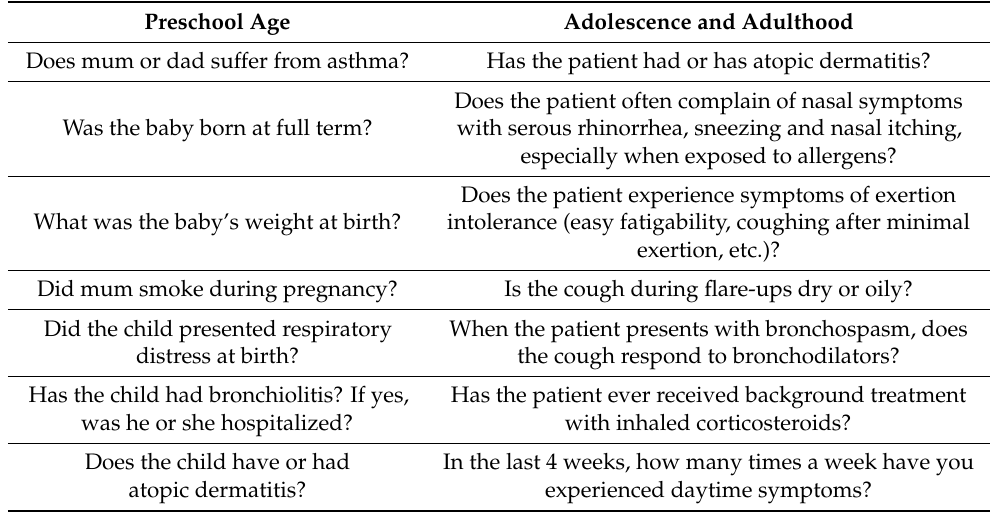
Table 1. Useful questions for asthma diagnosis by teleconsultation in children and